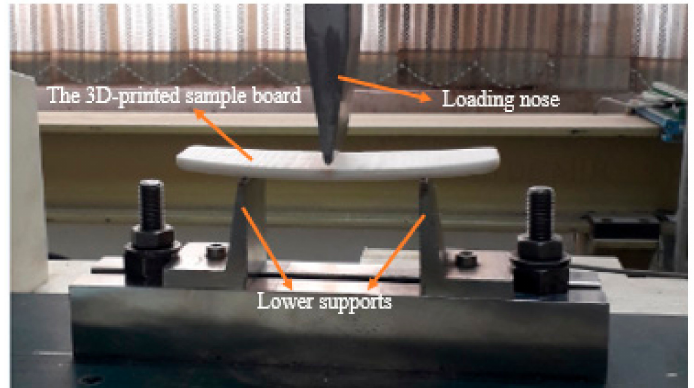
Figure 8. The board with a uniform honeycomb structure core under three-point bending